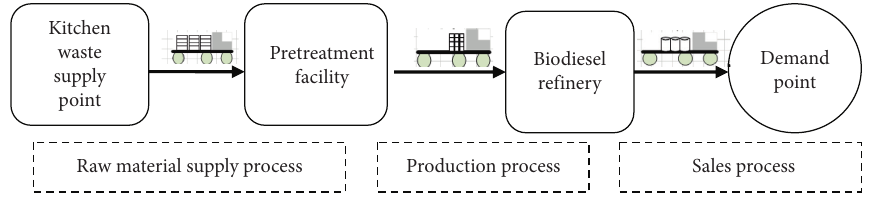
Figure 2: Sustainable WCO for biodiesel supply chain